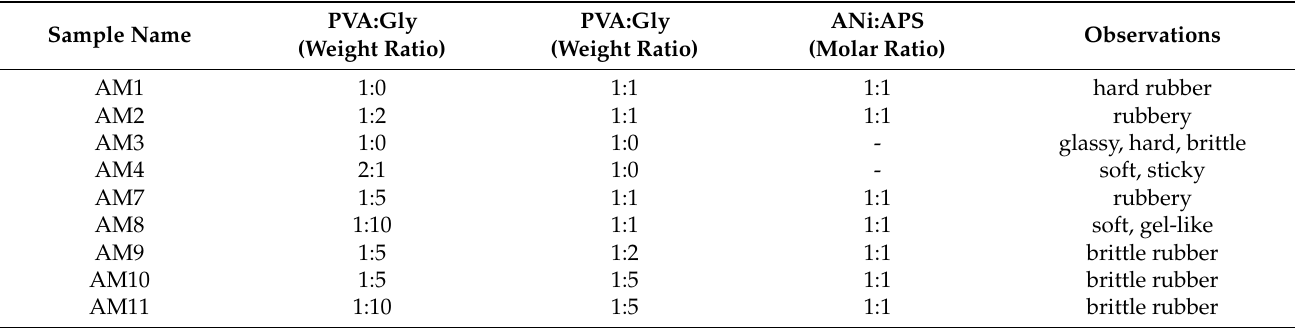
Figure 1. ( A ) Preparation procedure of the PANi/PVA elastic composite starting from (i) the prepa- ration of the hydrogel matrix as reaction medium for the aniline polymerization, followed by the addition of the aniline and the polymerization initiator APS, (ii) cooling of the mixture and the polymerization initiation of PANi, (iii) removal of the sample from the cooling chamber and drying at room temperature. ( B ) The resistance and conductivity of the elastic PANi/PVA composite was measured with compression and relaxation cycles in a four-point electrode configuration and the mechanical compression was controlled by a micromanipulator. Table 1. Composition of the hydrogel according to the weight ratio of the components PVA:Gly, PVA:Gly and the molar ratio between the aniline monomer (ANi) to the APS oxidant